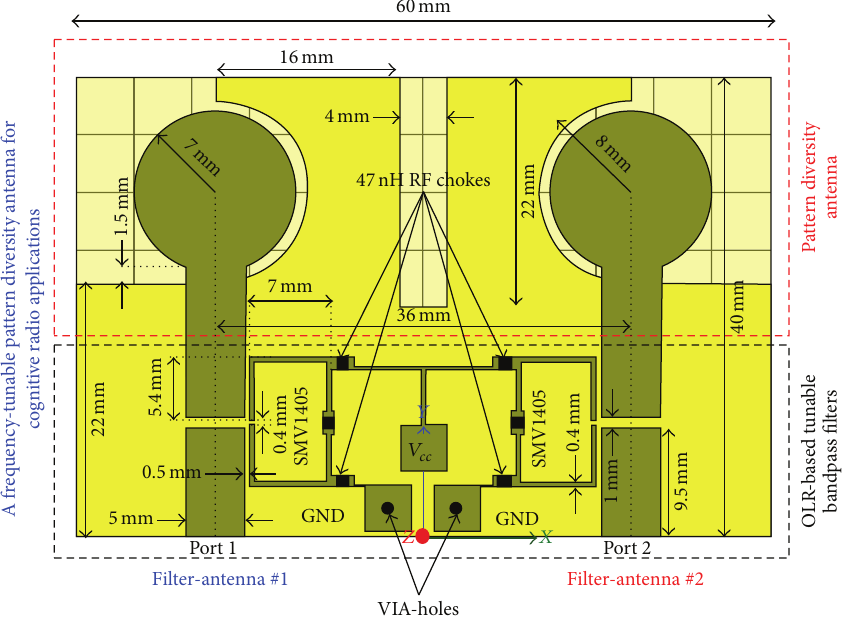
Figure 13: Configuration of the proposed pattern diversity tunable